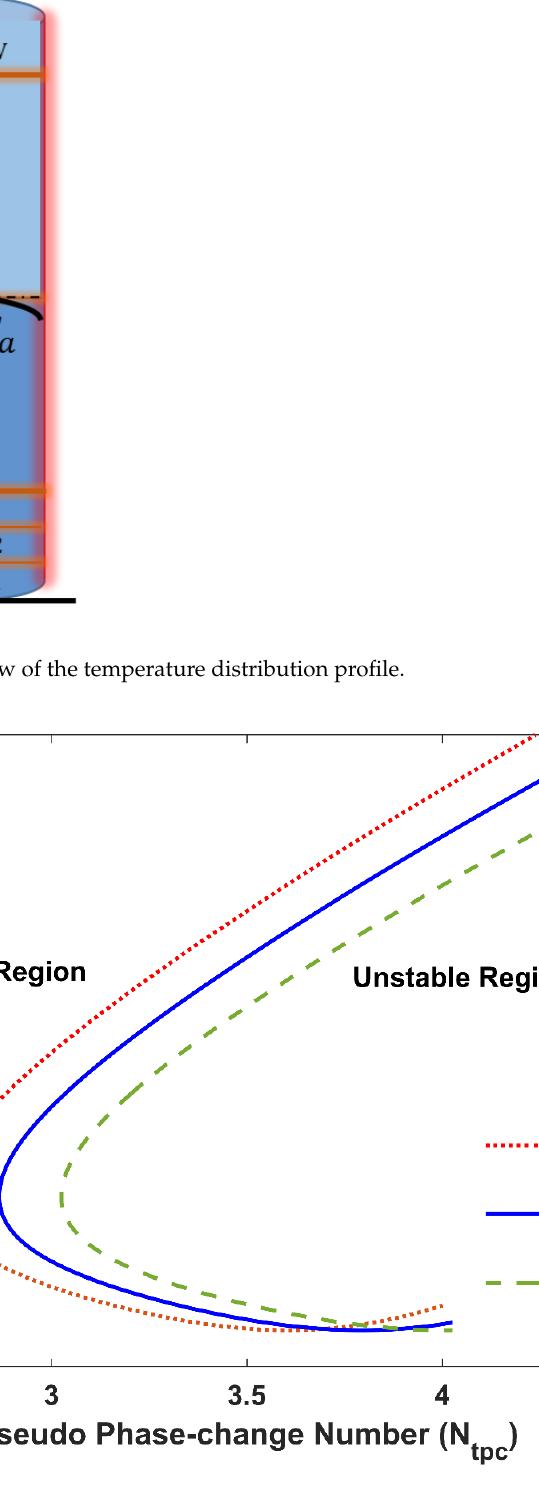
Figure 15. Wall heat effect on the stability boundary.